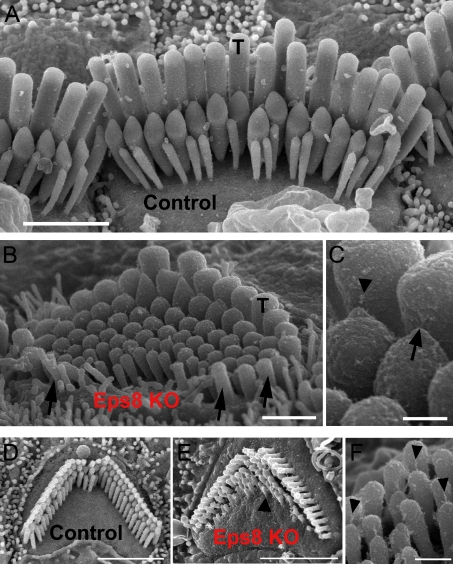
Hair bundle morphology in hair cells from adult Eps8 mice.(A) Scanning electron micrograph (SEM) showing the typical hair bundle structure in control adult mouse P18 IHCs. Note that, generally, IHC hair bundles are composed of three rows of stereocilia. The tall stereocilia are indicated by T. Scale bar: 2 µm. (B) SEM showing that tall stereocilia (T) appear to be truncated in adult Eps8 knockout mice. Arrows indicate taller stereocilia oriented opposite to those positioned in the direction of bundle sensitivity. Moreover, additional rows of short stereocilia (three in this case) are present compared to wild type mice. Scale bar: 1 µm. (C) Higher magnification micrograph showing a tip link (arrow) and tip-link remnant (arrowhead) in an IHC from an Eps8 knockout mouse. Scale bar: 250 nm. (D–F) Outer hair cell hair bundle morphology in Eps8 mice. SEM showing the typical hair bundle structure of a second row (from the modiolus) OHC from the middle region of a normal wild type adult mouse cochlea (panel D). The precisely arranged rows of stereocilia with well defined height increments can be seen. (E) A comparable hair bundle from an Eps8 adult mutant mouse. Note that all the stereocilia in equivalent rows appear shorter, and the shortest row has missing stereocilia. Additional rows of stereocilia are also present (arrowhead). Scale bars: 2.5 µm. (F) Detail of the hair bundle of an OHC from row 1 showing numerous tip links including some that are single filaments (arrowheads). Scale bar: 300 nm.